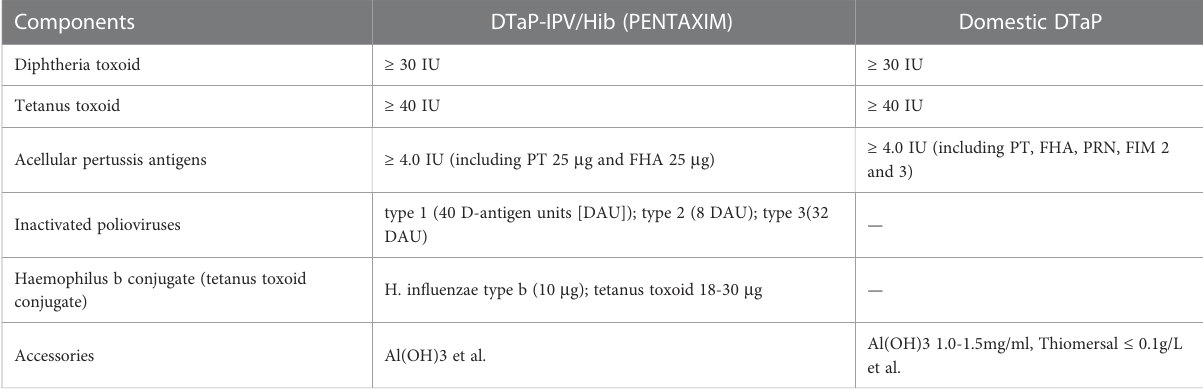
TABLE 1 Components and properties of DTaP-IPV/Hib and DTaP in each 0.5 mL dose.